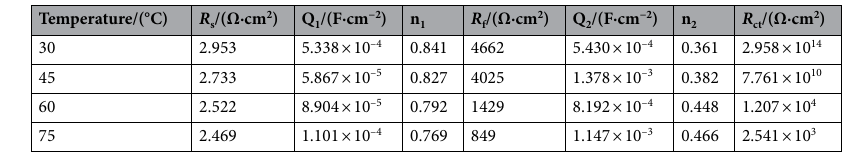
Table 3. EIS fitting results of 2205 DSS in simulated solution containing 100 g/L Cl - and saturated CO 2 at different